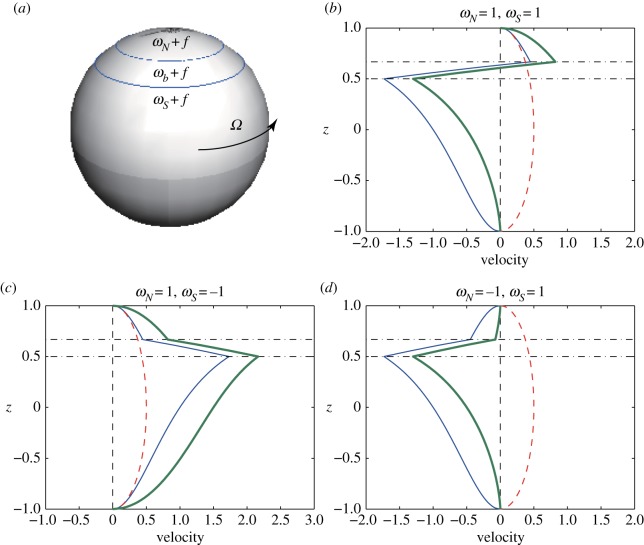
(a) Schematic of the vorticity distribution of a vortex strip on a rotating sphere. (b–d) Profiles of the zonal velocity. The vorticity constants are given by (b) (ωN,ωS)=(1,1), (c) (ωN,ωS)=(1,−1) and (d) (ωN,ωS)=(−1,1). The thick (green) curves represent the velocity fields induced by the vortex strip (2.3) between zb1=2/3 and zb2=1/2 on the rotating sphere with the angular speed Ω=0.5. The thin (blue) curves and the dotted (red) curves represent the velocity fields induced only by the zonal strip, i.e. (2.3) with Ω=0, and by the solid body rotation, respectively.